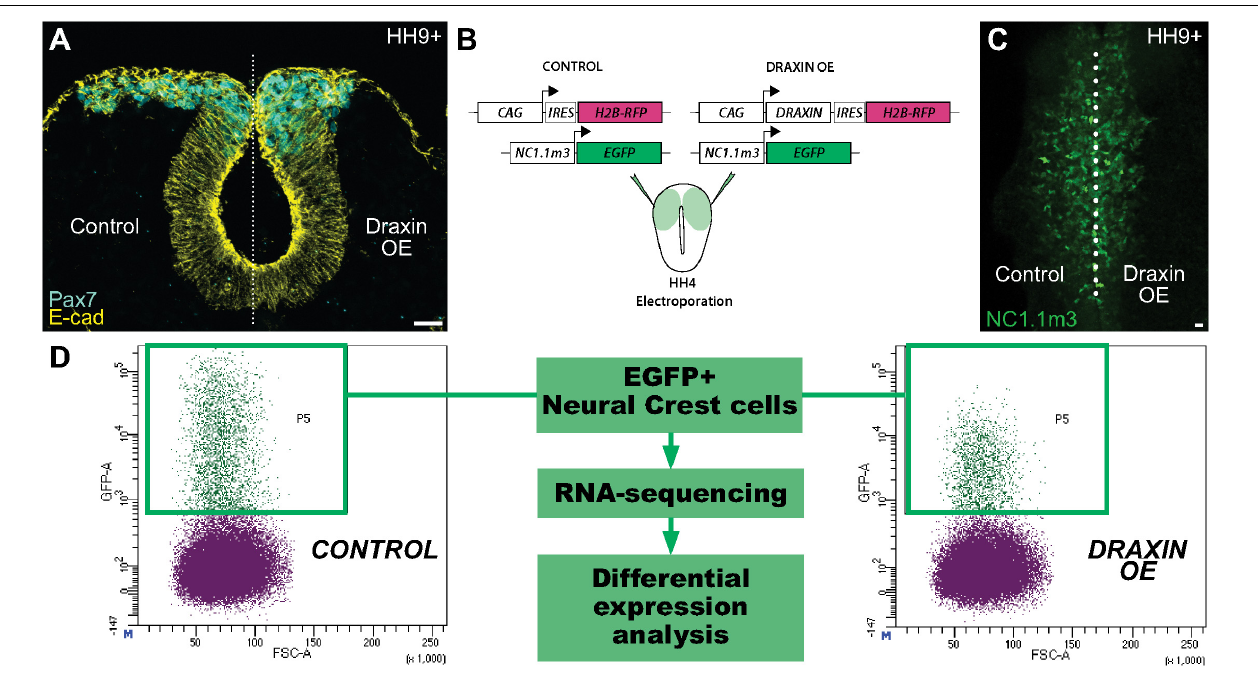
FIGURE 1 | Experimental design for identification of Draxin-responsive targets in cranial neural crest EMT. (A) Cross-section through embryo electroporated with a Draxin overexpression construct on the right side of the embryo. Immunostaining for E-cadherin (E-cad) and the neural crest marker Pax7 at HH9+ highlights the deleterious effects of Draxin overexpression on cranial neural crest EMT and migration away from the midline (dotted line), compared to the contralateral control side. (B–D) Experimental design to isolate cranial neural crest cells with or without Draxin overexpression. Gastrula stage chick embryos were co-electroporated with a neural crest-specific enhancer driving EGFP expression in cranial neural crest cells (NC1.1m3) and either a Draxin overexpression or control construct (B) . NC1.1m3 enhancer expression revealed EGFP + cranial neural crest cells were responsive to Draxin overexpression and exhibited EMT defects (C) . Fluorescence activated cell sorting (FACS) was used to isolate EGFP+ cranial neural crest cells with and without Draxin overexpression that were subsequently processed for RNA-sequencing and differential expression analysis (D) . Scale bar, 20 µ m. HH, Hamburger-Hamilton stage; OE, overexpression; IRES, internal ribosomal entry